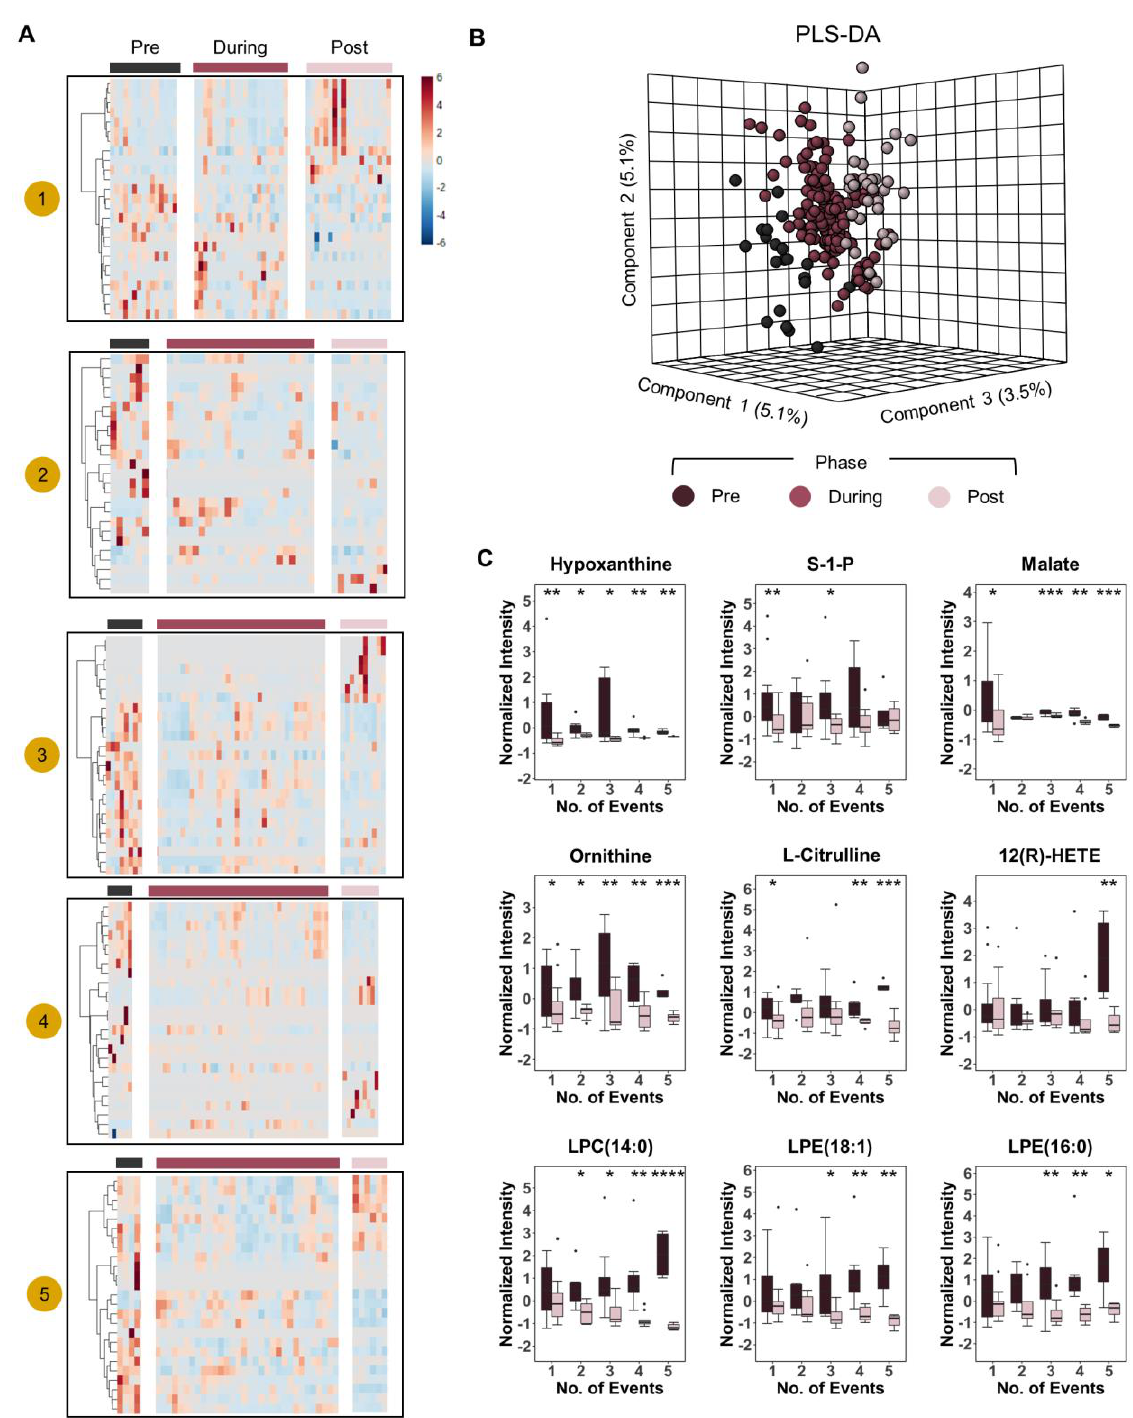
Figure 4. Dose-response effect of pRBC transfusion on the plasma metabolome heat maps of top 25 metabolites that changed significantly in response to transfusion as measured by ANOVA (y-axis) with patients on the x-axis ( A ) . The heat maps were divided into transfusion phases “pre-during-post” grouped by the number of transfusion “events” 1 – 5. In panel ( B ), PLS-DA of patient metabolomes grouped by transfusion phase. Patients that received strictly greater than one transfusion event were included in PLS-DA. In ( C ) we show box plots of select metabolites that changed significantly in response to transfusions. Box plot colors correspond to pre and post transfusion time points, consistent with panels ( A , B ). **** p < 0.0001, *** p < 0.001, ** p < 0.01, * p <